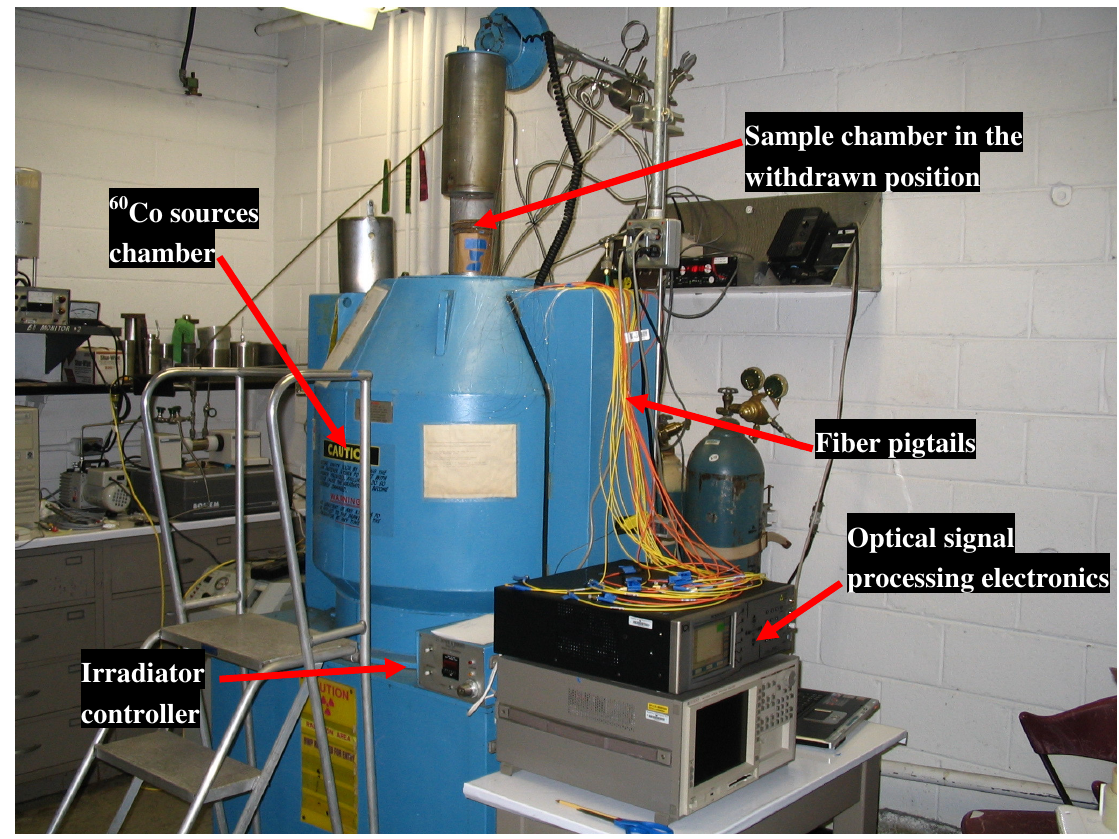
Figure 3. Fiber irradiation setup showing the J.L. Shepherd